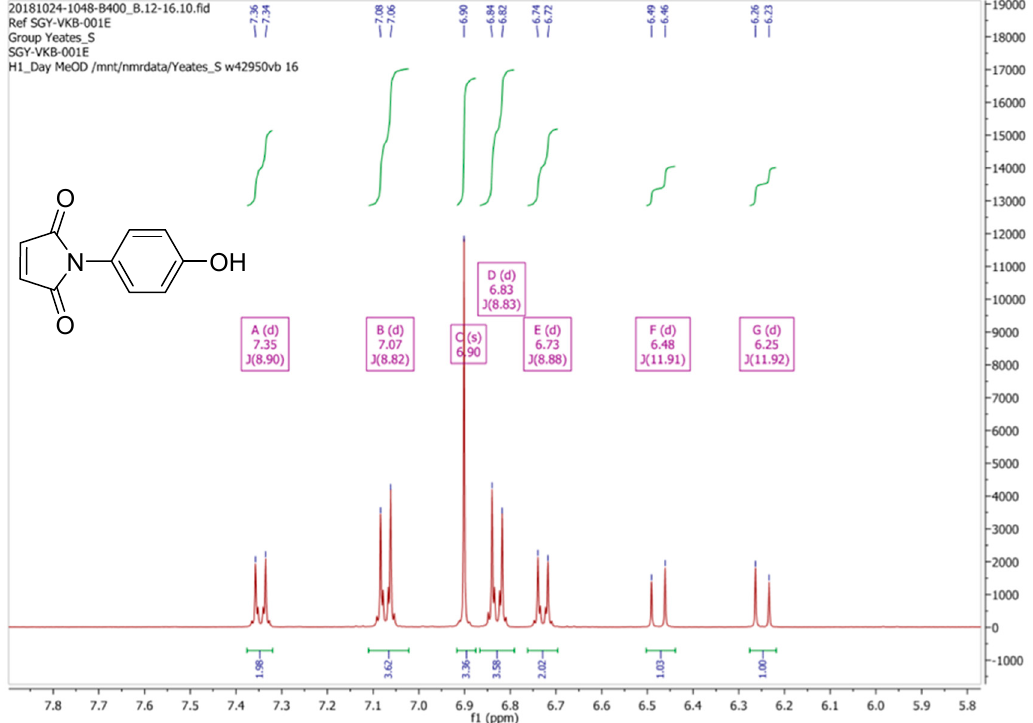
Figure 3. 1 H-NMR spectrum of N -(4-hydroxyphenyl)maleimide ( 2 ) recorded in CD 3 OD as prepared this study.